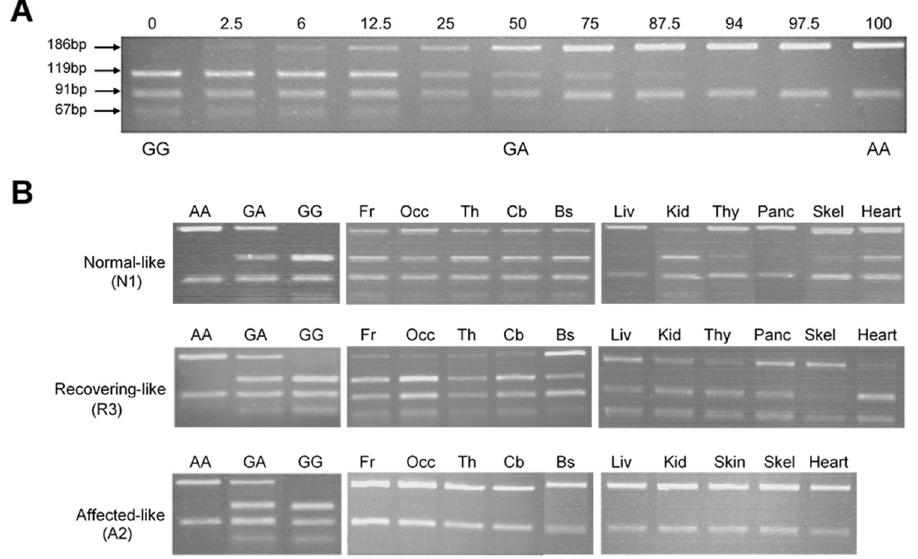
Fig 2. Restriction enzyme detection of the c.822G > A polymorphism to determine the extent of chimerism. A 277bp PCR product from normal (GG) sheep cleaved with HaeII results in three bands of 119, 91 and 67bp, affected (AA) sheep yield two bands of 186 and 91bp, and heterozygous (GA) sheep four bands of 186, 119, 91 and 67bp. A) Serial dilutions of affected and normal DNA which were used as a standard to estimate the proportion of affected DNA present in samples from chimeric animals by visual inspection. Numbers indicate the affected portion (%). B) Representative images of PCR products from brain and peripheral tissues for one animal from each experimental group (See S1 Raw images and Table 1 for full data set). Fr: Frontal cortex, Occ: Occipital cortex, Th: Thalamus, Cb: Cerebellum, Bs: Brainstem, Sc: Spinal Cord, Liv: Liver, Kid: Kidney, Thy: Thyroid, Panc: Pancreas; Skel: Skeletal